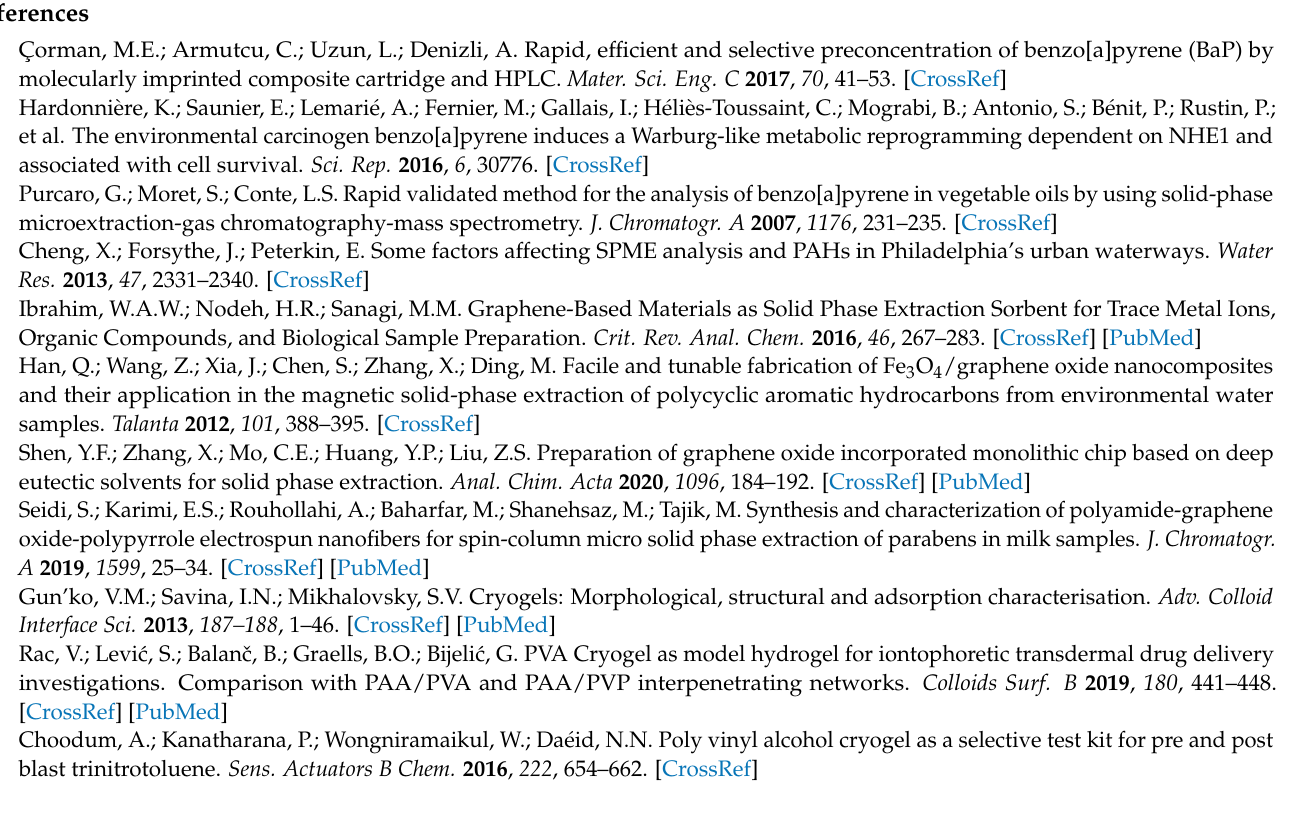
Figure S3: (a) GO-Cry with amounts of GO from 0 to 150 mg from the left-hand side, (b) GO-Cry and conventional C 18 SPE cartridge